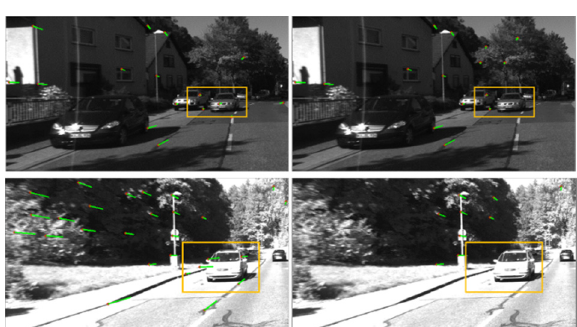
Figure 11. Comparison before and after corresponding point verification (Left (a): before, Right (b): after) In Figure 10 and 11, the green line indicates the feature movement direction between previous and current images. The red dot indicates the head direction. Ideally, the feature motion vector should appear to spread out around one point as Figure 10. However, as mentioned in Section 2.3, abnormal feature Figure 13. All experimental results by proposed method motion vectors were generated when the vehicle passed as (a) in Figure 11. We confirmed that although the number of points In case of sequence 08, a large error appeared to have occurred was reduced, unstable points were eliminated as (b) in Figure 11. as shown in Figure 13. However, it was the result that the error which occurred at the beginning was accumulated continuously. Numerically, the translation error was 5.43% and the rotation error was 0.005 degree per meter in sequence